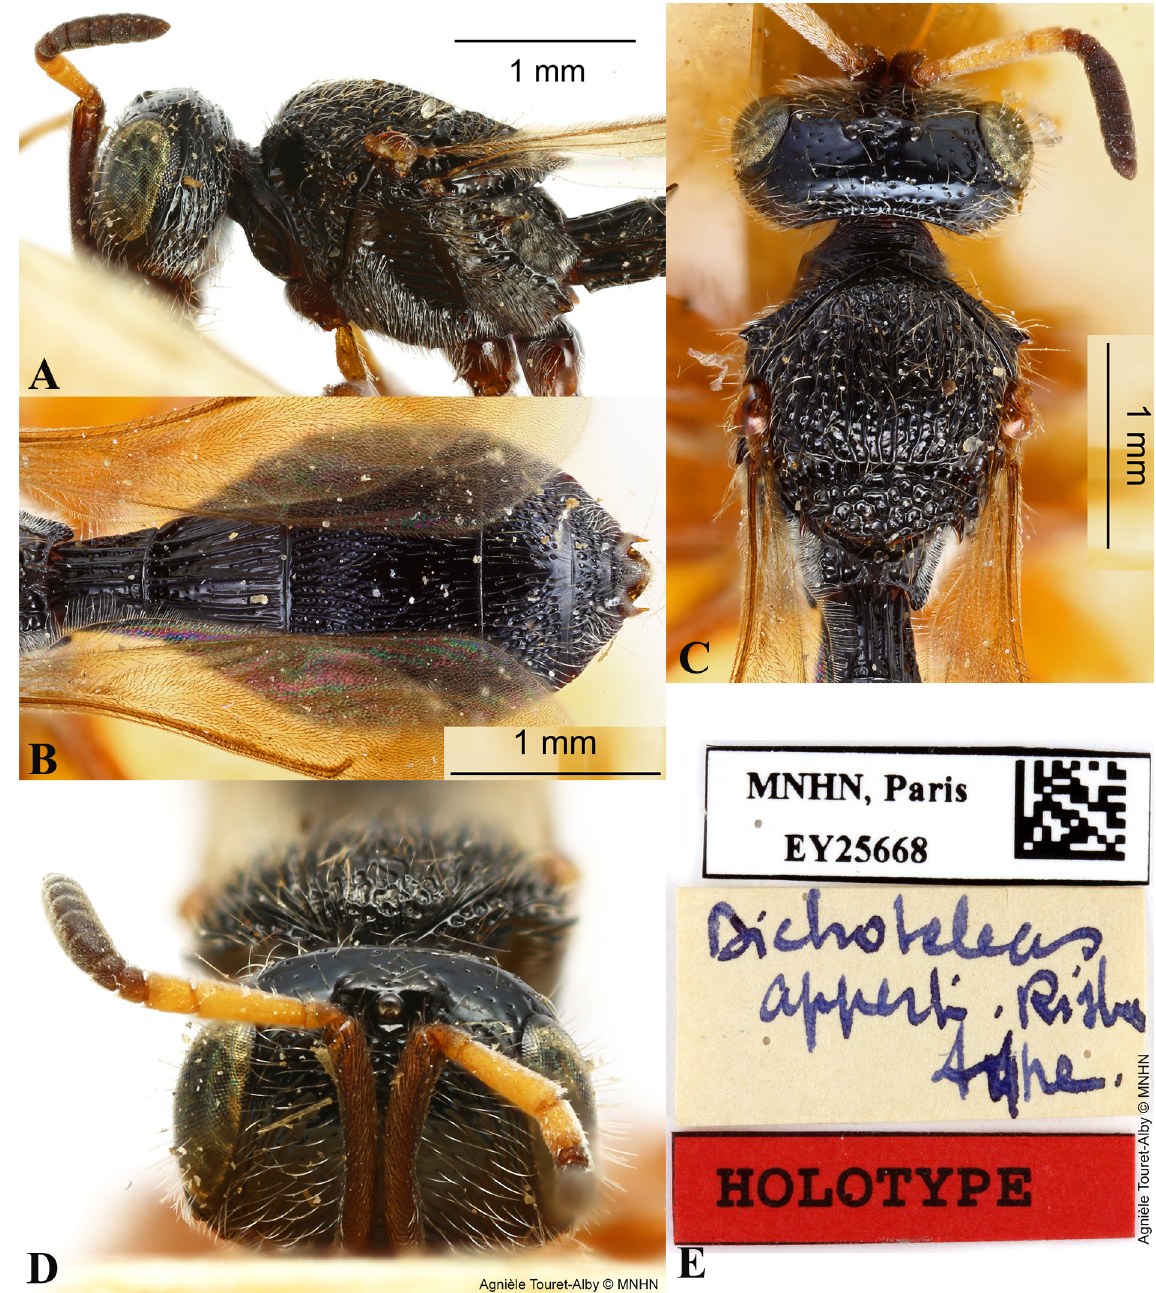
Fig. 6. Odontoscelio apperti (Risbec, 1953). Holotype, ♀ (MNHN EY25668). A . Head and pleuron. B . Metasoma. C . Head and mesoscutum. D . Frons, vertex and antennae. E . Type label. Photos: Agnièle Touret-Alby © ,